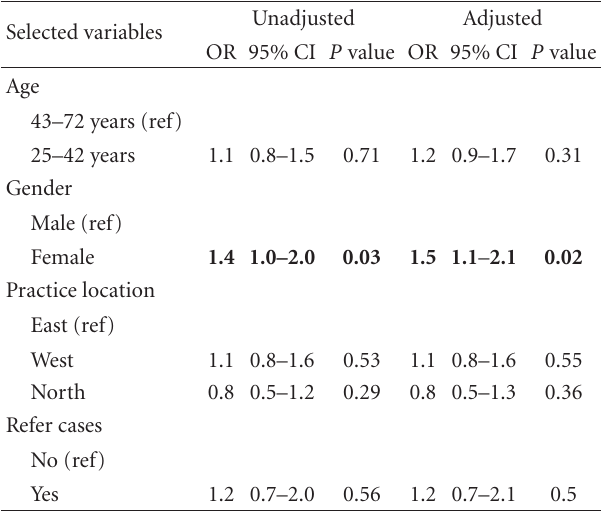
Table 3: Associations between selected variables and operative restoration of upper 1st molars. Results are presented as odds ratios (OR) with 95% confidence interval (CI). Results significant at 5% level are marked in bold. ref: reference